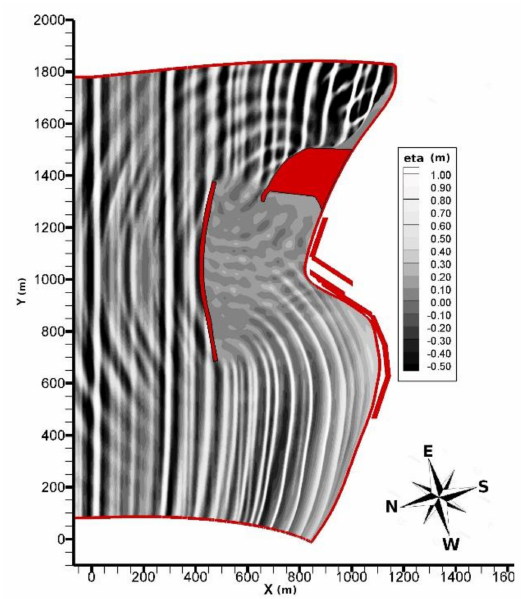
Figure 5. Instantaneous wave field. Present sea bottom level. Configuration 1.